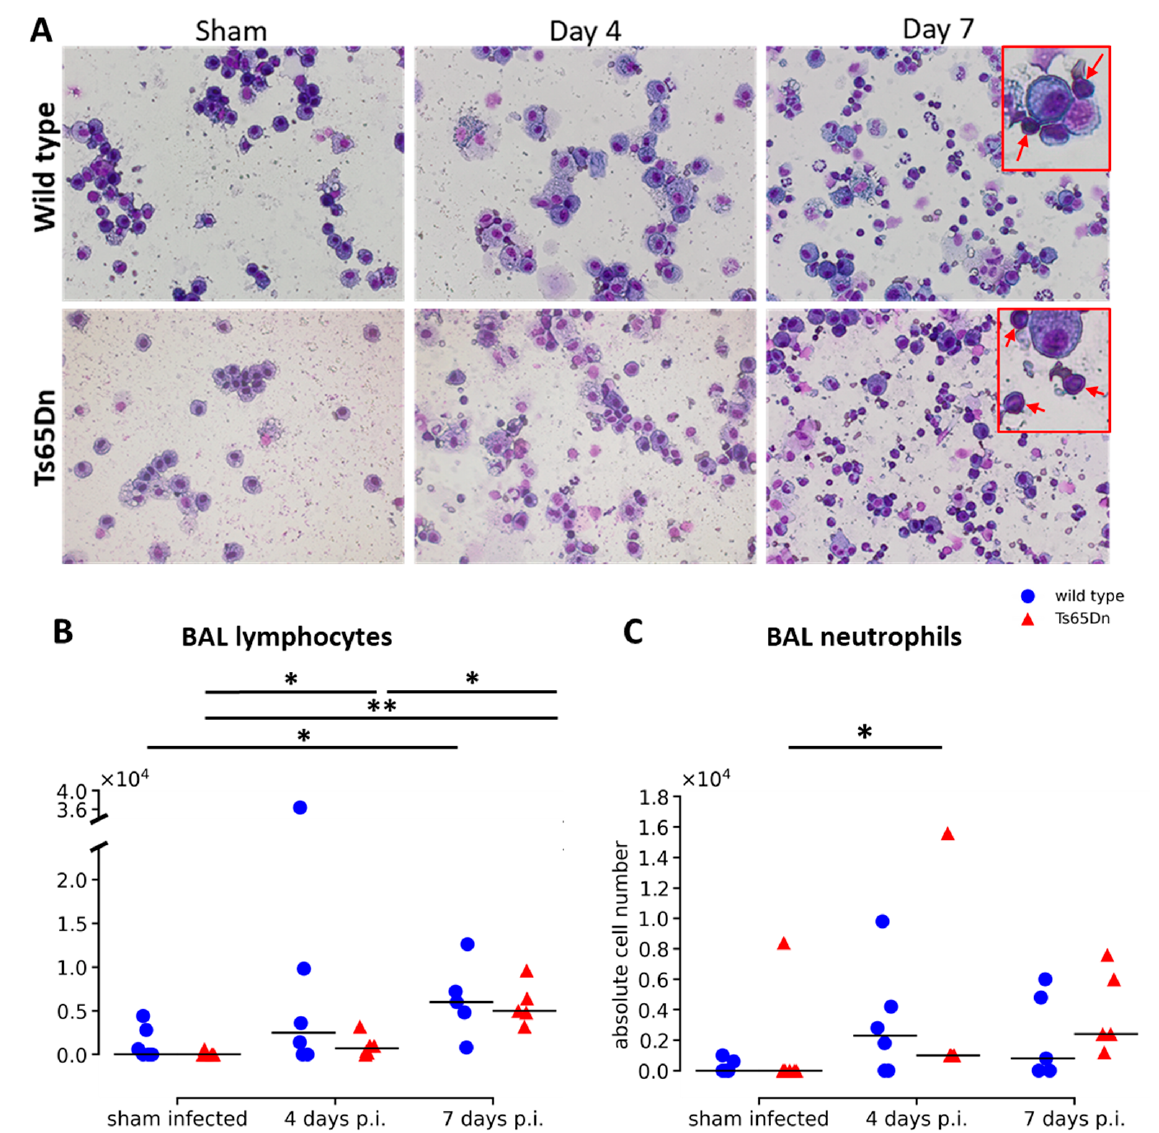
Figure 4. RSV infection causes airway inflammation. ( A ) Representative images of BAL from sham infected, four day infected, and seven day infected wild type and Ts65Dn mice with rhRSV-Luc indicating lymphocytes (red arrow). ( B ) Analysis of the number of lymphocytes. ( C ) Number of neutrophils in wild type (blue circle) and Ts65Dn (red triangle) mice at each time point and expressed as individual values and group median. * p < 0.05, ** p < 0.01.